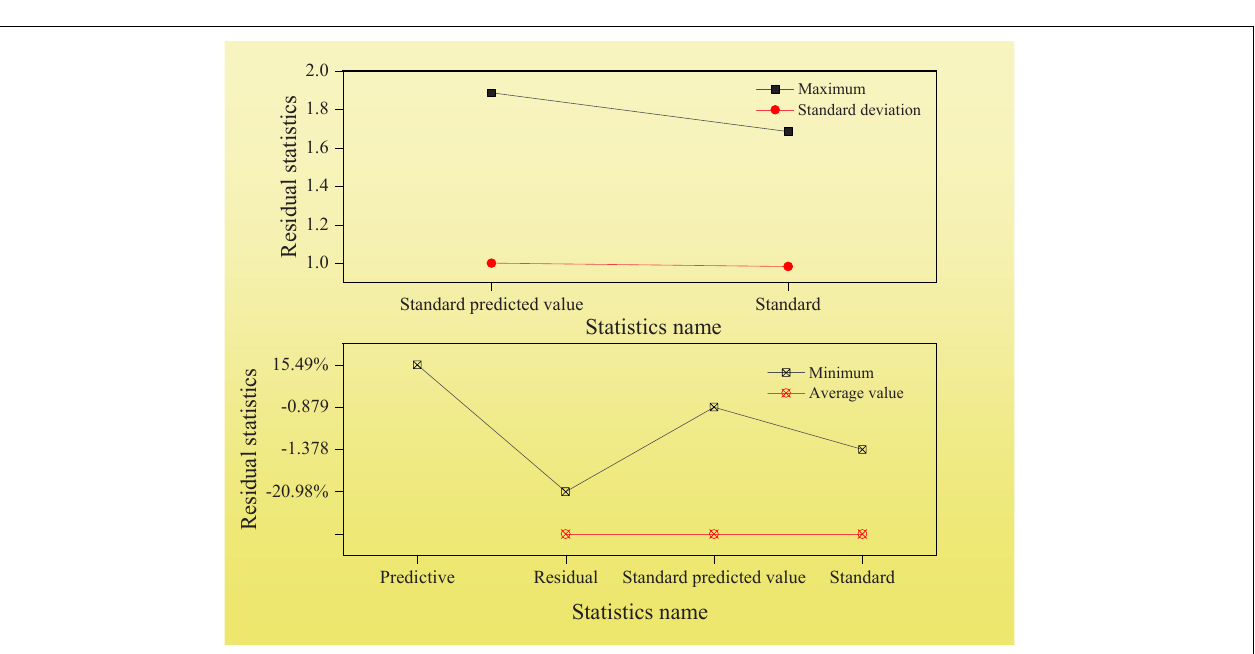
FIGURE 7 | Collinearity diagnostic diagram of the linear regression test between the number of likes of social media associated with the content and the growth rate of CSR scores. In the figure, the dependent variable of the scale is the growth rate of the score, and the predictive variable is the number of likes.